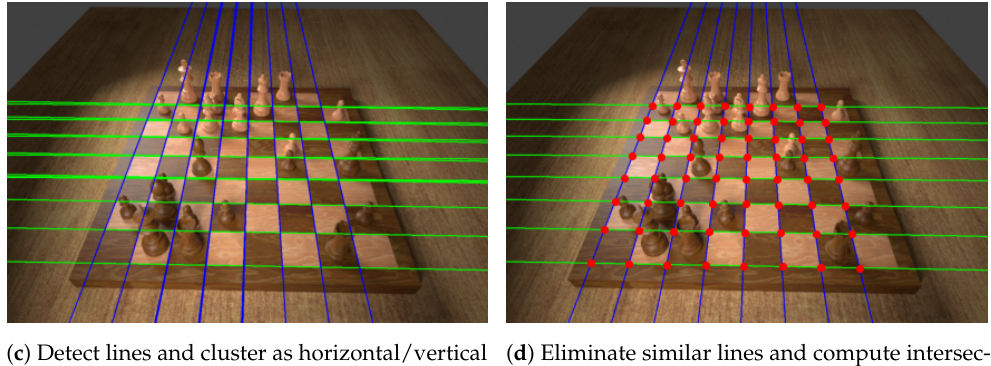
Figure 2. The process of determining the intersection points on the